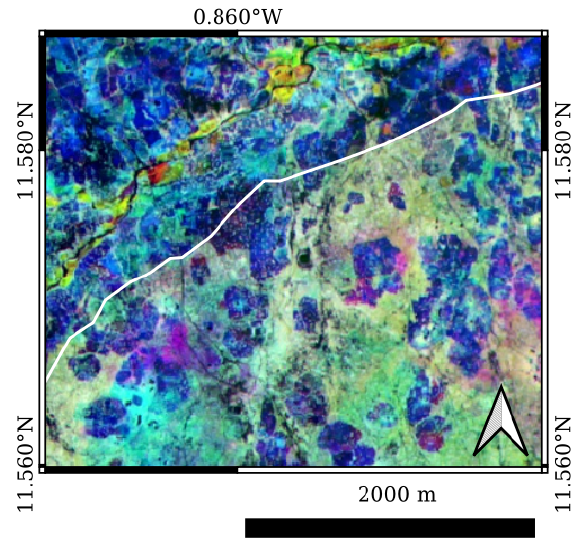
Figure 11: A 2018 3PTS image Cropland in Niassa on the north- ern border of zone (border in white),EPSG